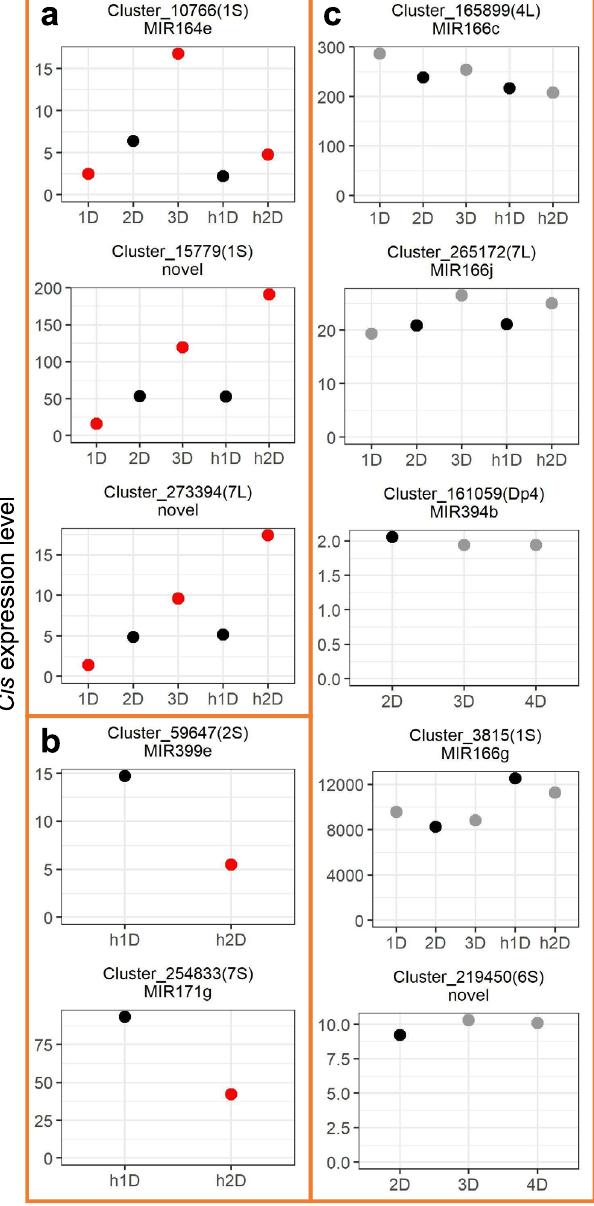
Fig. 8 Expression patterns of cis MIRNAs . The x-axis refers to the dosage of the cis chromosomal region within parentheses, whereas the y-axis designates the cis expression level (rpm) of each MIRNA . Each MIRNA cluster was annotated as described in “ Methods ” . Novel MIRNAs denote o nes that failed to match any preexisting annotation. Differential MIRNA expression was computed as described in Fig. 2. Control groups were painted in black. MIRNAs with FDR < 0.05 compared with the control were depicted in red, whereas ones with FDR ≥ 0.05 were depicted in gray. a Example MIRNAs showing a dosage effect. b Example MIRNAs showing a negative dosage effect. c Example MIRNAs exhibiting dosage compensation. Source data are provided in Supplementary Data